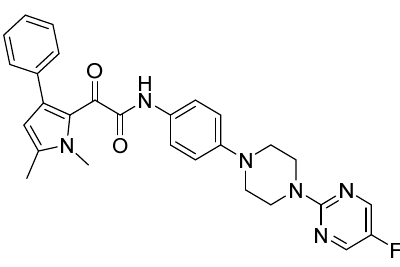
Figure 7. The chemical structures of olorofim.